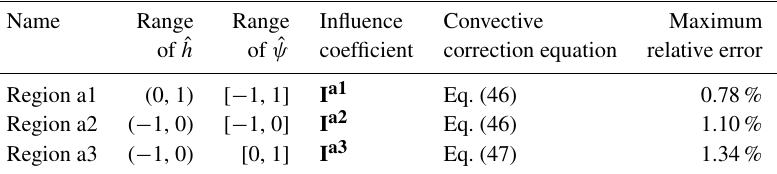
Table 1. The definition of the three regions for the parameter space of the equivalent relative position ˆ h , the normalized sweep angle ˆ ψ and the corresponding influence coefficients for the axial induction. The equation of the convective correction and the maximum relative error of the fitted induction are also